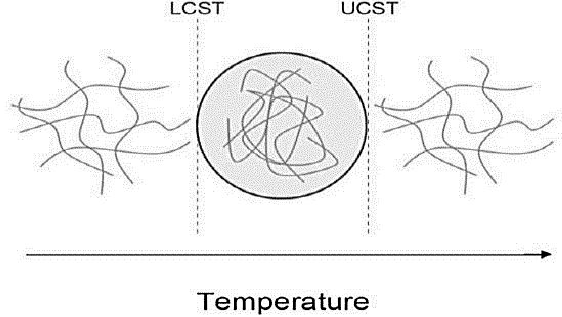
Figure 7. Reversible phase transition of thermo-responsive polymers (taken from [9]).